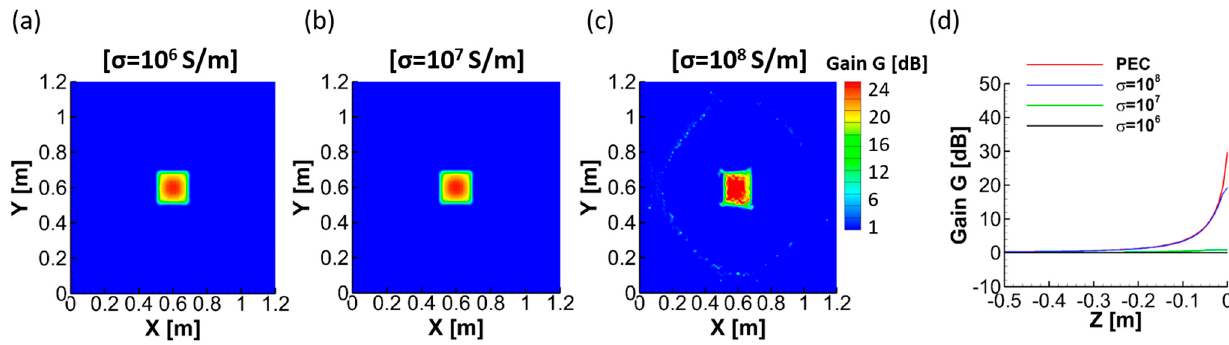
Figure 6. The G values for different conductivities of inside and outside boxes at 50 Hz magnetic fields. ( a – c ) Different conductivities of the outer shell for PEC inside box. ( d ) Different conductivities of the inside box through an outer shell that has 10 6 S/m conductivity. The relative permeability of all cases is 1.